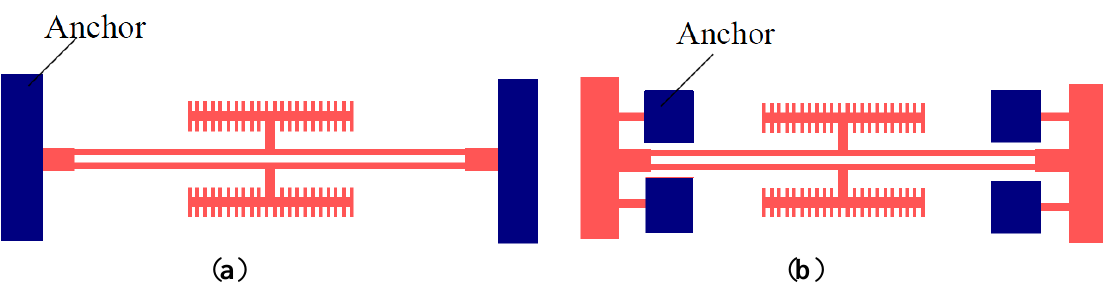
Figure 2. ( a ) The common DETF structure; ( b ) The improved DETF structure.